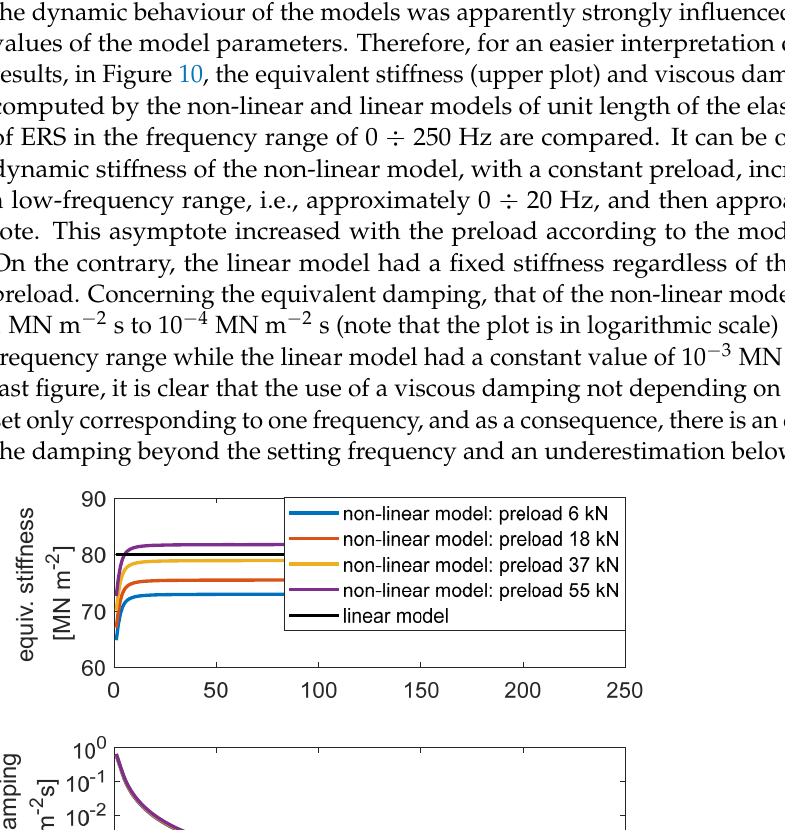
Figure 11. Free responses simulated by the non-linear and linear mechanical model of unit length of the reference ERS subjected to a constant force of 55 kN with null initial conditions. The response of the linear model had a period of approximately 0.0054 s (185 Hz) and decreased logarithmically with time. The 185 Hz corresponds to the natural frequency of